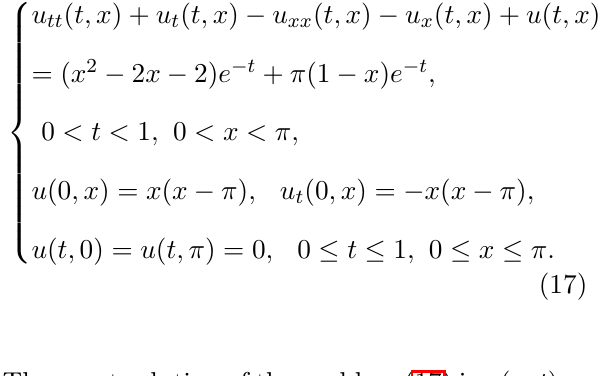
Figure 2. Figure of approxima- tion solution for problem 16, where